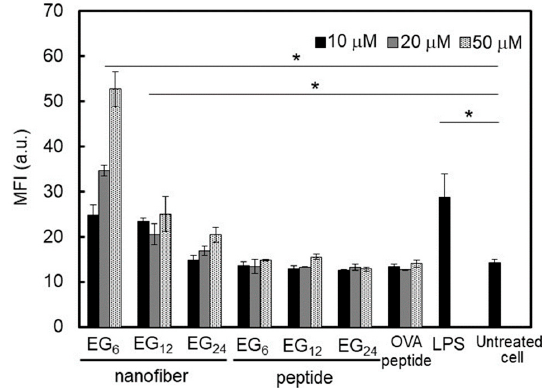
Figure 8. Evaluation of CD86 expressed on the surface of JAWS II cells co-incubated with EG n NFs (10–50 µ M), EG n peptides (10–50 µ M), the OVA peptide (SIINFEKL, 10–50 µ M), or 1 µ g · mL − 1 LPS at 37 ◦ C for 24 h. CD86 expression was analyzed by FCM. Each result is the mean ± SD ( n = 3). * p < 0.01. a.u. represents arbitrary unit.